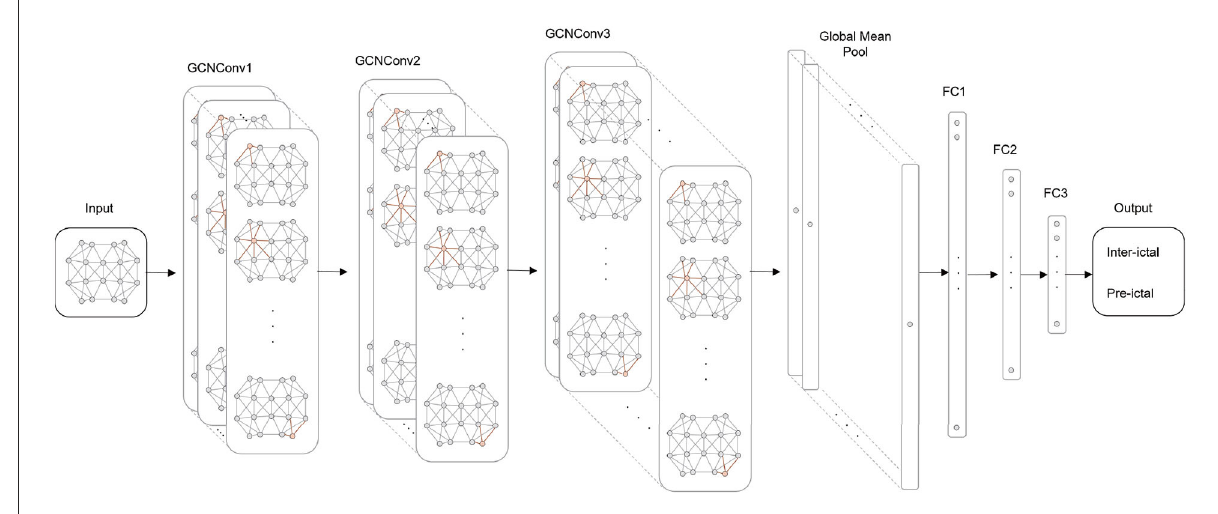
FIGURE3 The GCN architecture for seizure